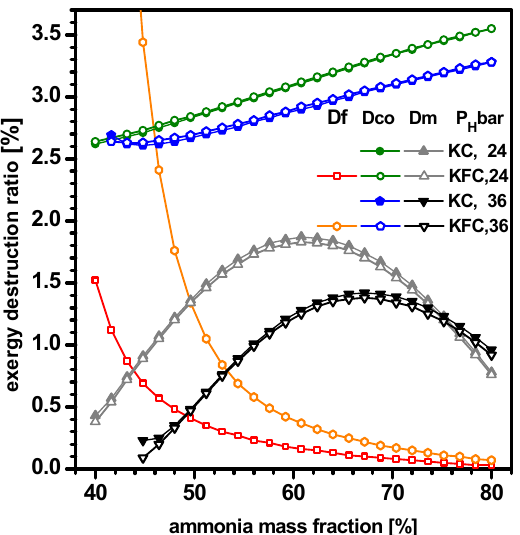
Figure 9. Dependence of Df , Dco , and Dm on ammonia mass fraction for P H = 24, 36 bar in the KC and KFC.